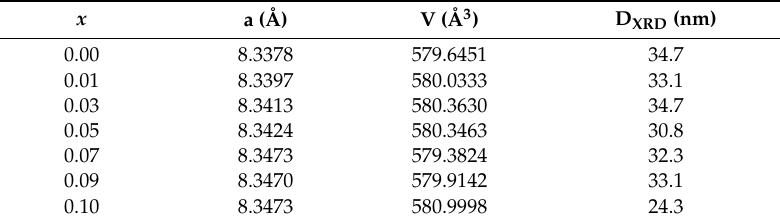
Table 1. Structural parameters of studied NiDy x Fe 2 − x O 4 NPs.